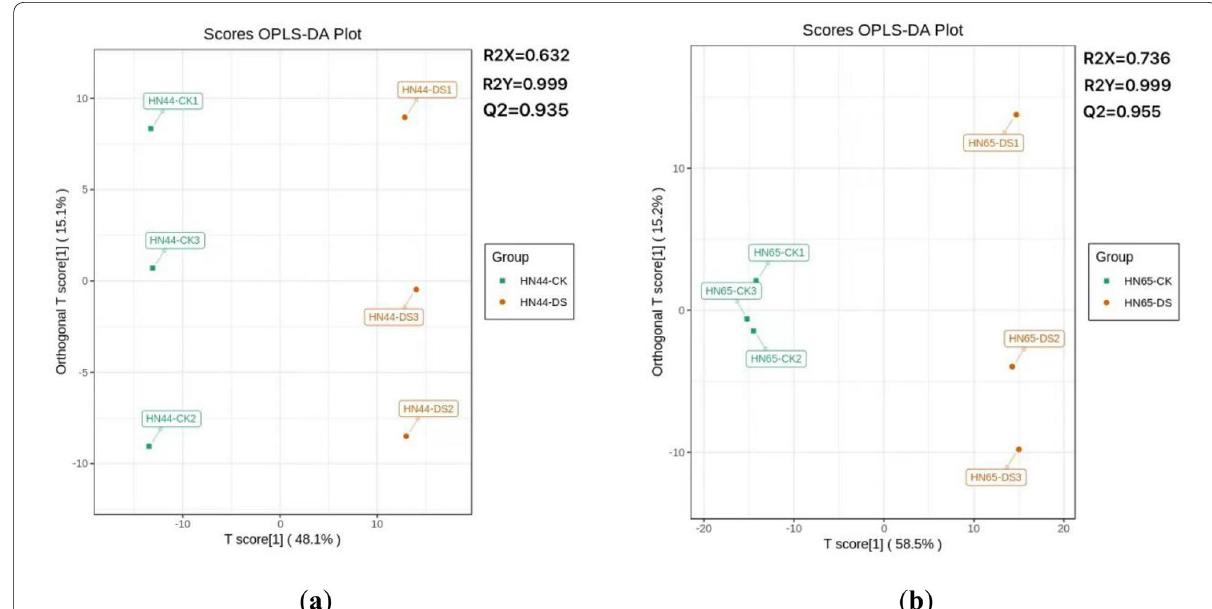
Fig. 4 OPLS-DA score plots between the following pairs of groups: a HN44-CK vs. HN44-DS; b HN65-CK vs. HN65-DS. Note: R 2 X, R 2 Y and Q 2 indicate original model values, the abscissa indicates the similarity between Y after replacement and original Y, and the ordinate indicates R 2 Y and Q 2 values. The evaluation model prediction parameters were R 2 X, R 2 Y and Q